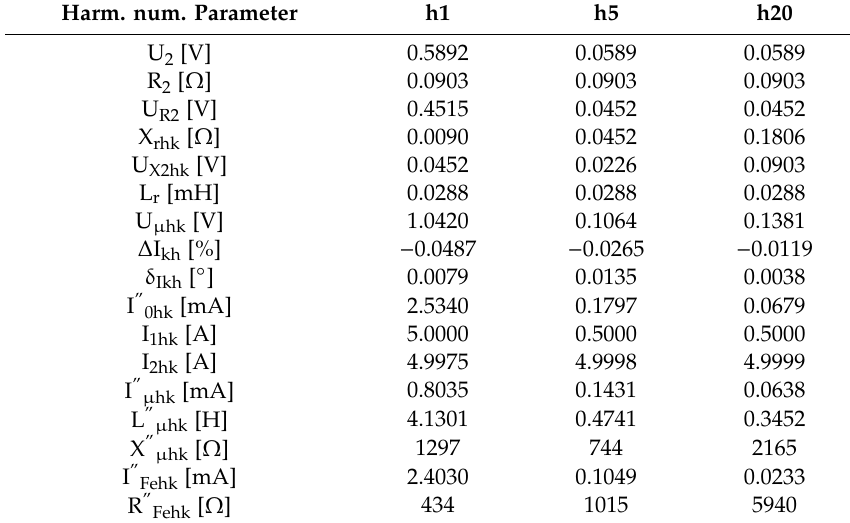
Table 2. Values of parameters of the equivalent circuit from Figure 1b for 1st (h1), 5th (h5), and 20th (h20) harmonics of distorted primary